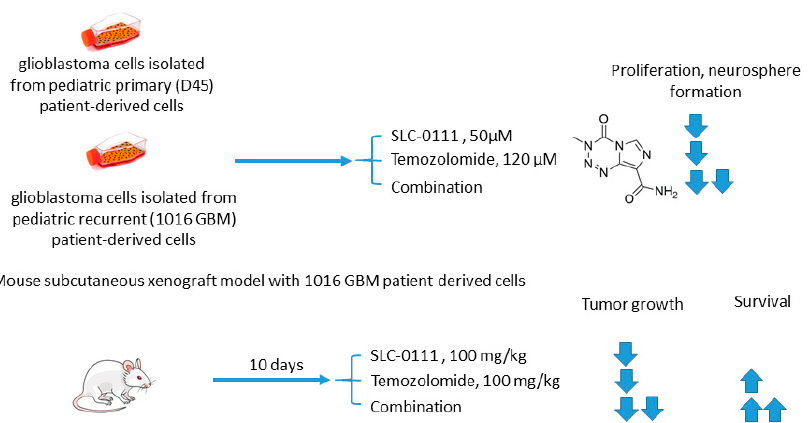
Figure 10. Graphical outline of the study on SLC-0111+dacarbazine/temozolomide/DOX/5- fluorouracil combination reported by Andreucci et al. [69].